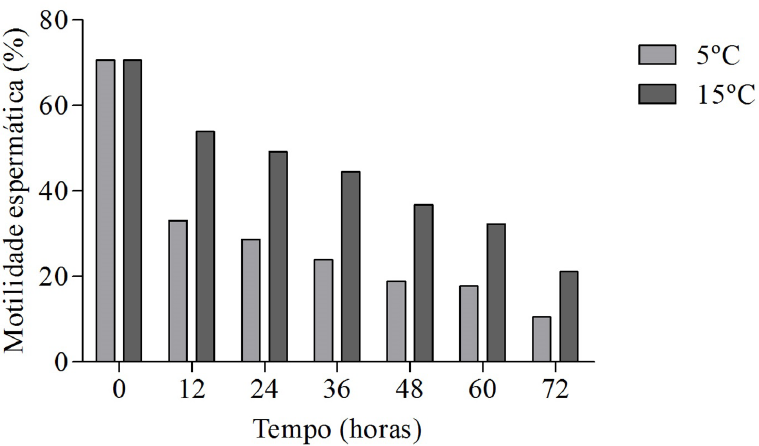
Figura 1. Médias de motilidade (%) das amostras de sêmen submetido à refrigeração nas temperaturas de